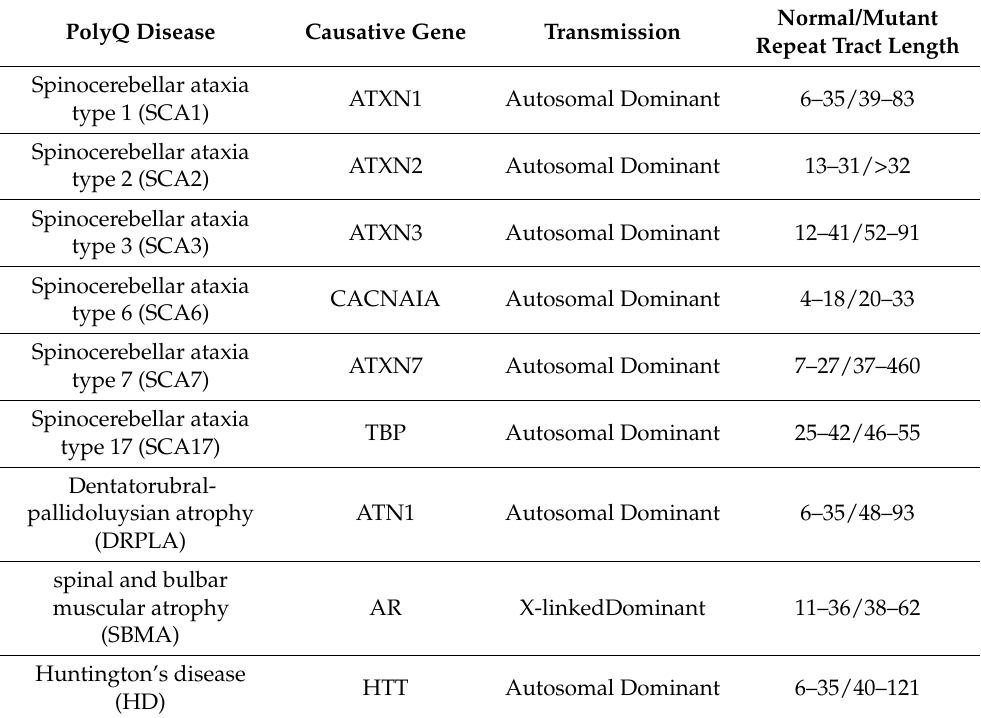
Table 1. Genes involved in the pathogenesis of polyQ diseases along with their manner of transmis- sion and the number of repeats that characterize them as normal or pathogenic. PolyQ Disease Causative Gene